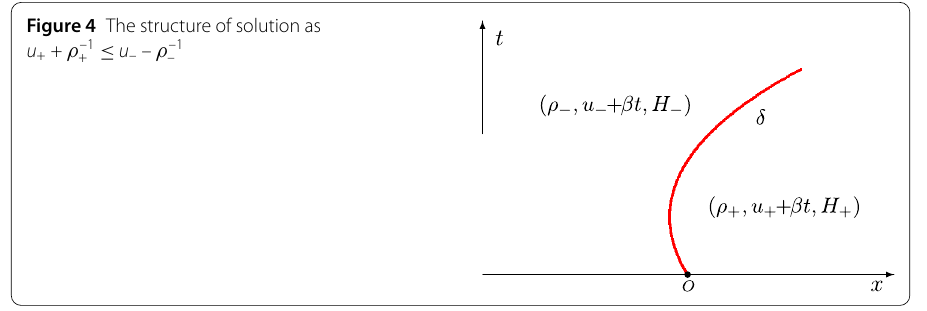
Figure 4 The structure of solution as